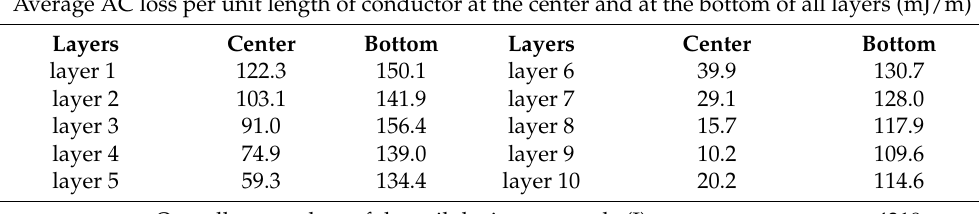
Table 4. Main loss of the SMES coil during one discharge–charge cycle at full